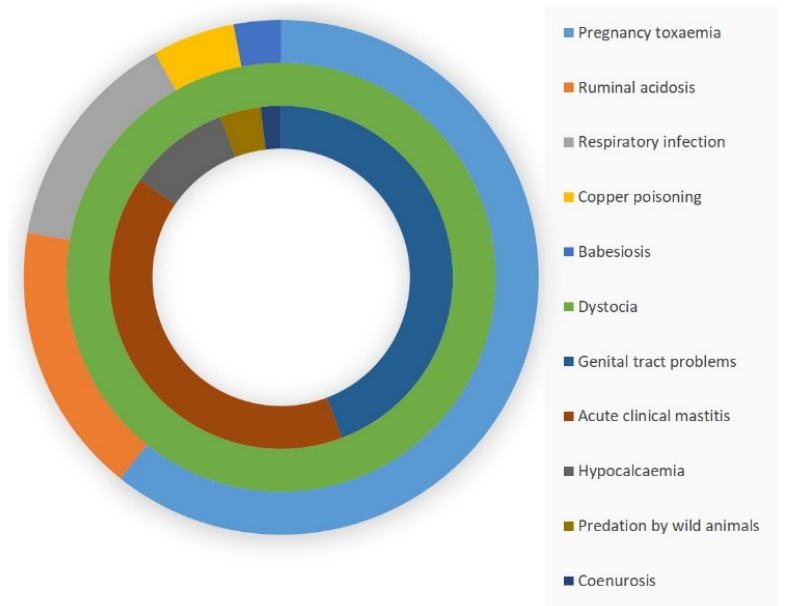
Figure 2. Ring-pie of the relative frequency of clinical problems associated with peri-parturient deaths in relation to the time of lambing: outer ring, associated with deaths before lambing (duration: 10 days); middle ring, associated with deaths at lambing (duration: 1 day); inner ring: associated with deaths after lambing (duration: 7 days).